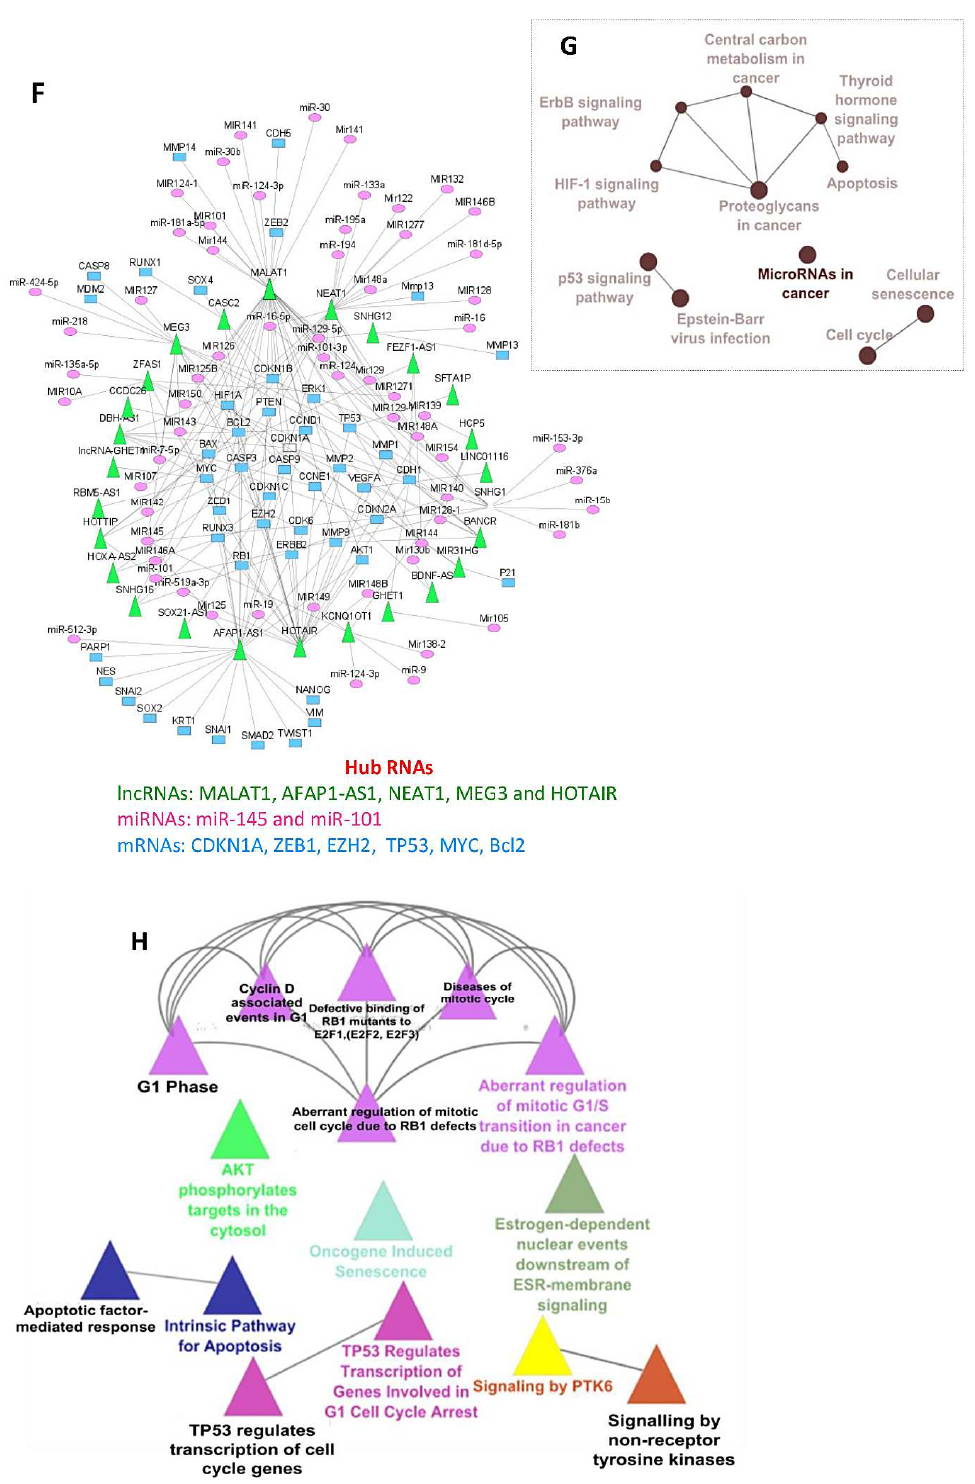
Figure 5. ( A ) Heat map of differentially expressed lncRNAs in retinoblastoma serum small extracel- lular vesicles. Functional enrichment of lncRNA-target genes: ( B – D ). Gene ontology (BP- Biological process, MF-Molecular function and CC- Cellular component) analysis and ( E ). Kyoto Encyclope- dia of Genes and Genomes (KEGG) enrichment results. ( F ) lncRNA-miRNA-mRNA interactions in retinoblastoma serum-derived small extracellular vesicles. Selected enriched ( G ) KEGG terms and ( H ). GO-Biological processes terms for protein-coding mRNAs in the